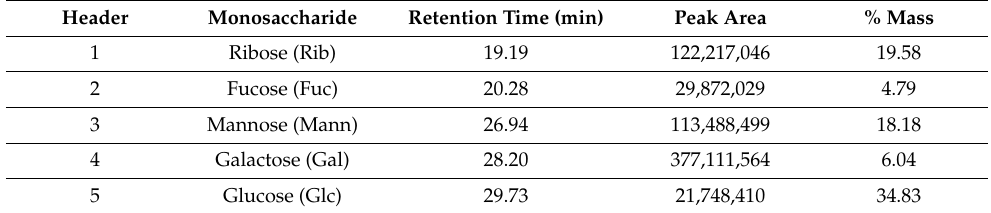
Figure 2. GC – MS of the EgPs. For peak description see Table 3. Figure 2. GC–MS of the EgPs. For peak description see Table 3. Table 3. Content of monosaccharides in EgPs. Table 3. Content of monosaccharides in